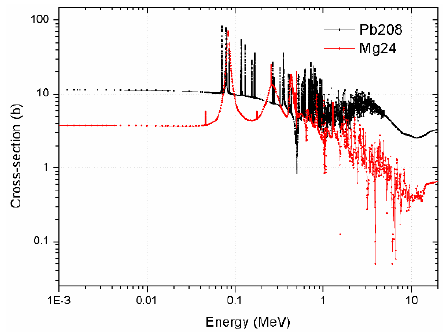
Figure 5. Elastic scattering cross sections for the major isotopes of reflector material [17].